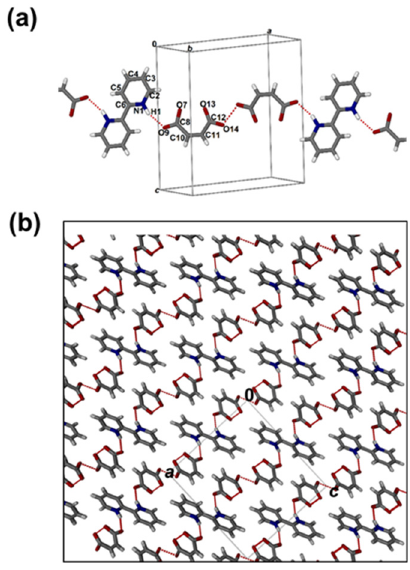
Figure 3. ( a ) 1D chain of BPY 2H + ·2MAL − formed by the interaction between BPY 2H + and MAL − and ( b ) The packing diagram of BPY 2H + ·2MAL − viewed down the b axis.